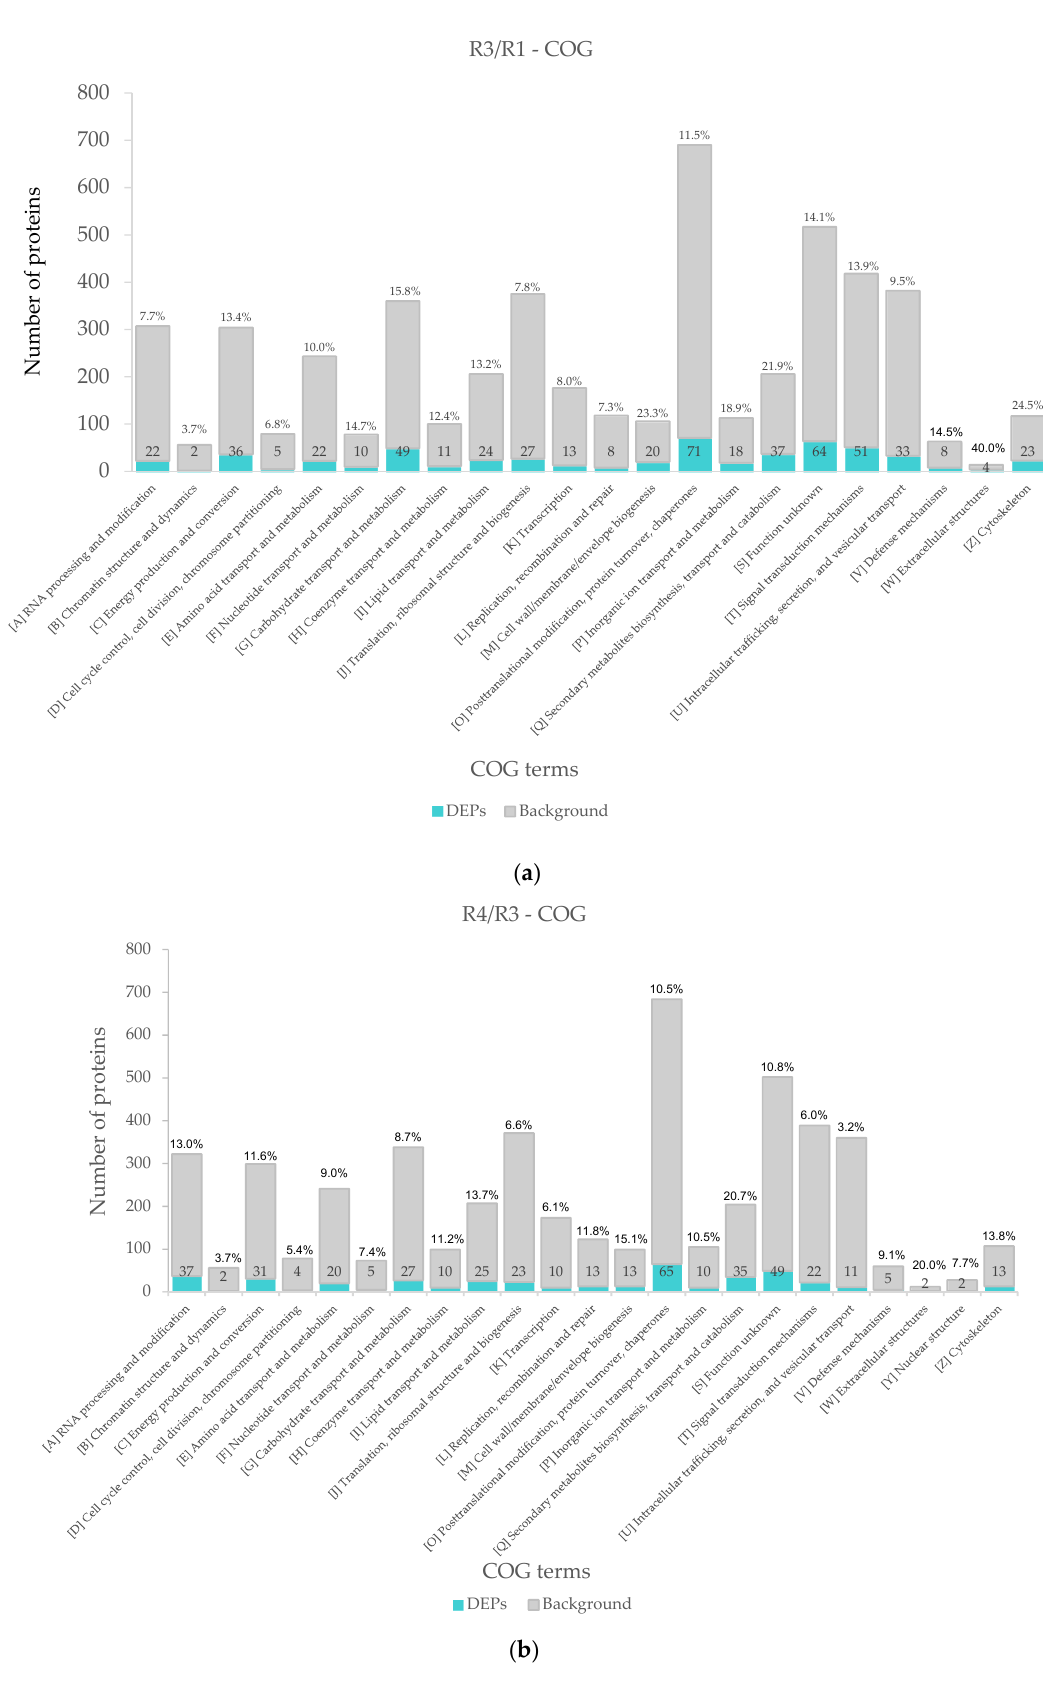
Figure 5. COG classification. The gray part of the bar chart represents all proteins identified under this COG category (including non-differential proteins and DEPs). ( a ) COG classification of DEPS in R3/R1. ( b ) COG classification of DEPS in R4/R3.